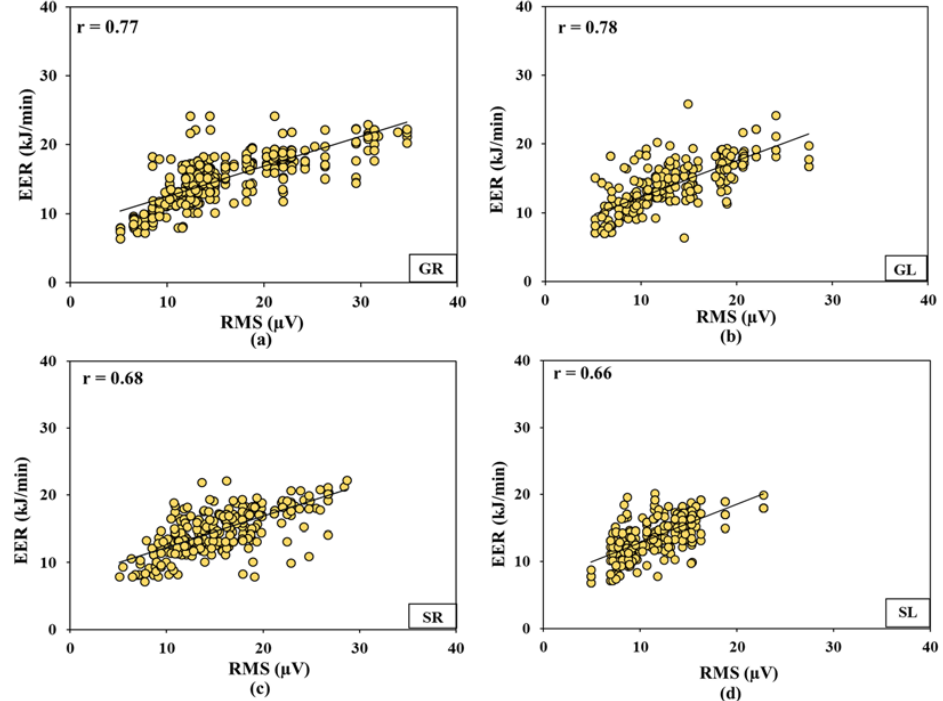
Figure 11. Correlation between electromyography feature (RMS) and energy expenditure rate for ( a ) gastrocnemius right, ( b ) gastrocnemius left, ( c ) soleus right, and ( d ) soleus left muscles. Right muscles: brake operation, left muscles: clutch operation.